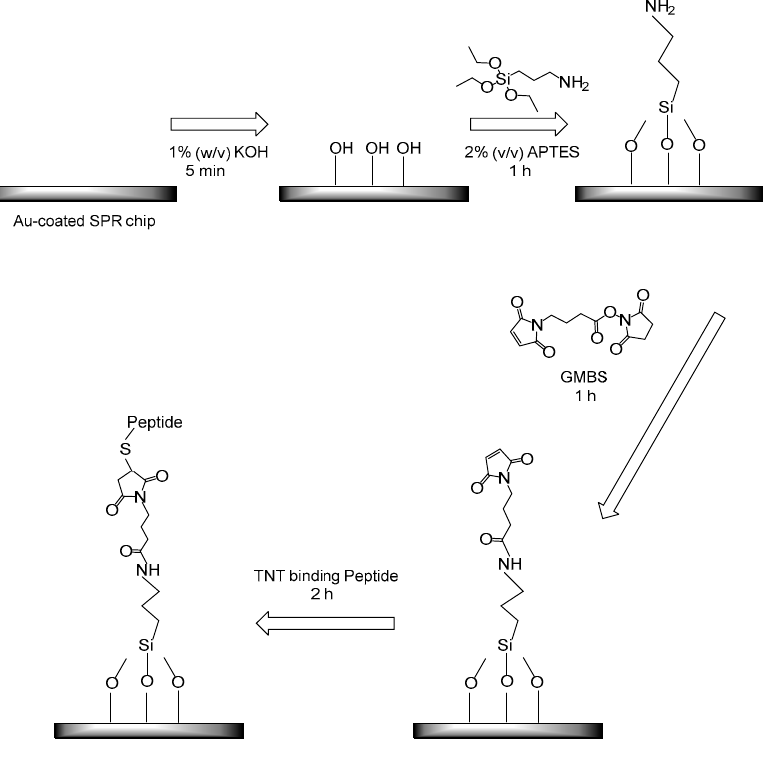
Figure 1. Immobilization procedure of the 2,4,6-trinitrotoluene (TNT) binding peptide on the surface of the surface plasmon resonance (SPR) Au-chip. APTES: 3-aminopropyltriethoxysilane; GMBS: N- γ -maleimidobutyryl-oxysuccinimide ester.